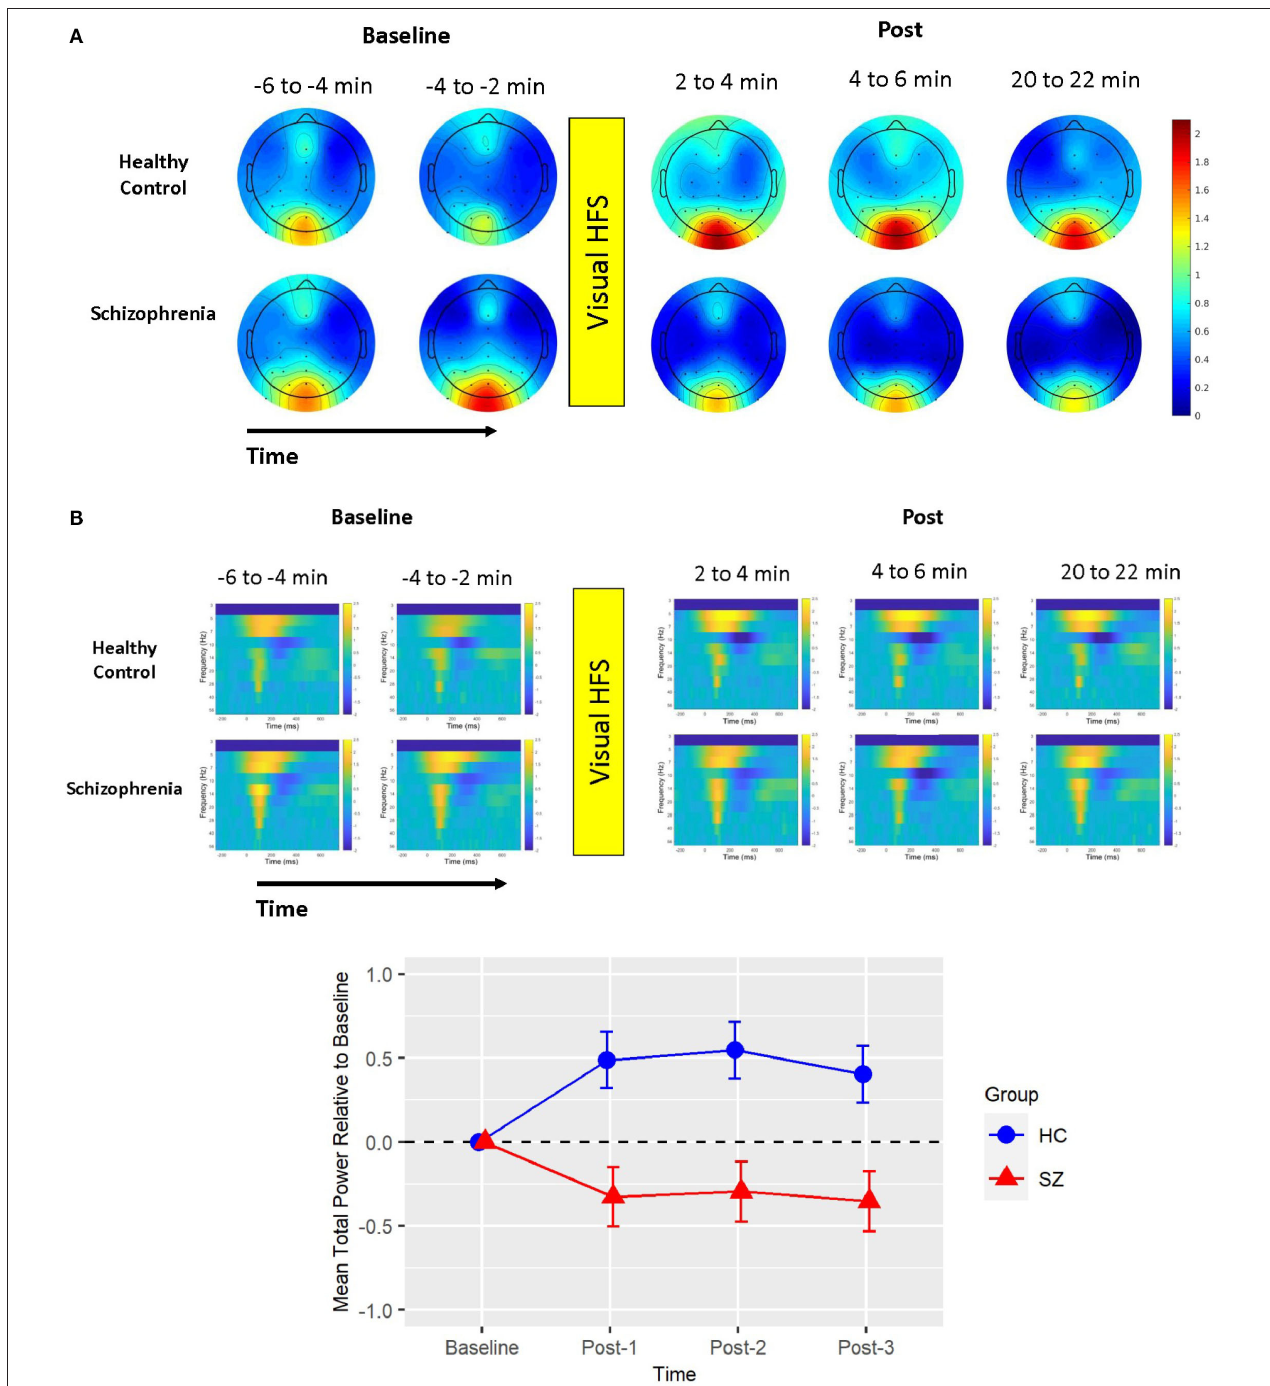
FIGURE 2 | Mean total power. (A) Voltage scalp topography maps are shown for the mean total power cluster, demonstrating prominent occipital/posterior activity. Topography maps are shown for each pre-VHFS and post-VHFS assessment block by group. All maps are plotted on the same voltage scale ( µ V) as indicated in the legend. (B) Group average mean total power values are shown over the first 800ms following the onset (time = 0) of checkerboard stimuli. Total power plots are presented for healthy controls (top) and schizophrenia patients (bottom) for each assessment block pre- and post-VHFS. (C) Graph showing change in mean total power in the identified cluster, which comprised of 5Hz (theta) activity in the 0–450ms time window, for post-VHFS assessment blocks relative to baseline. VHFS enhanced mean total power across post-VHFS blocks relative to baseline among healthy controls (shown in blue), whereas individuals with schizophrenia (shown in red) demonstrated a trend toward reduced mean total power baseline. Error bars denote standard errors within groups.